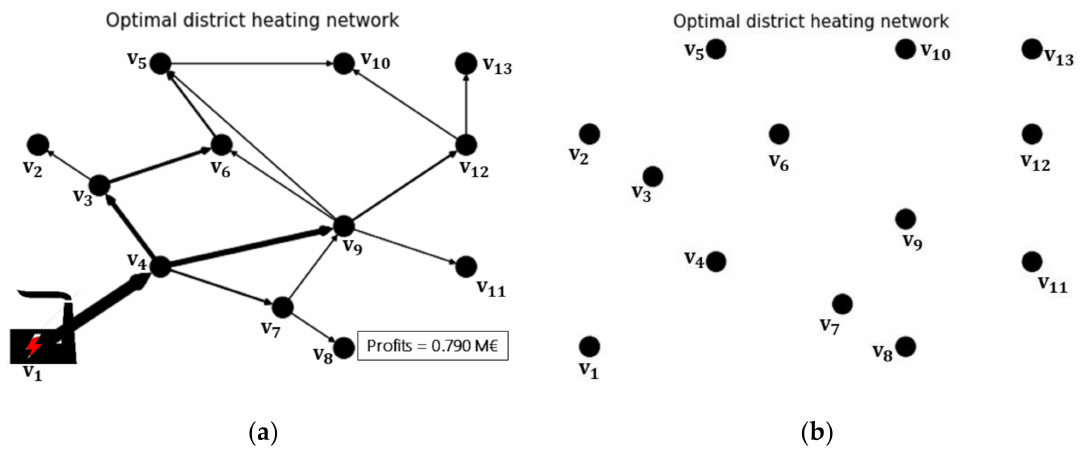
Figure 15. ( a ) a = 2%; ( b ) a =